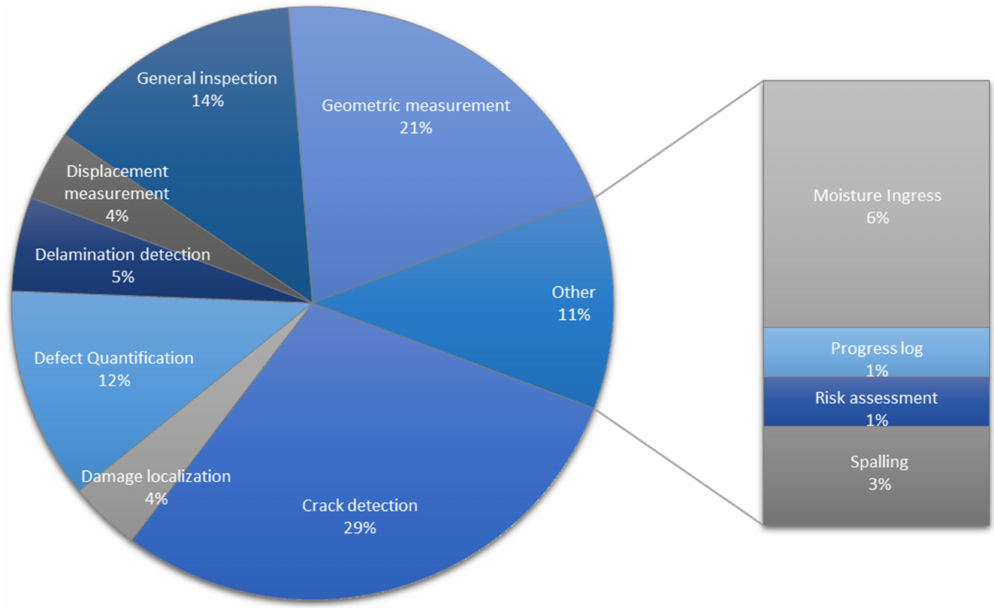
Figure 5. NDT-UAV applications in bridge condition